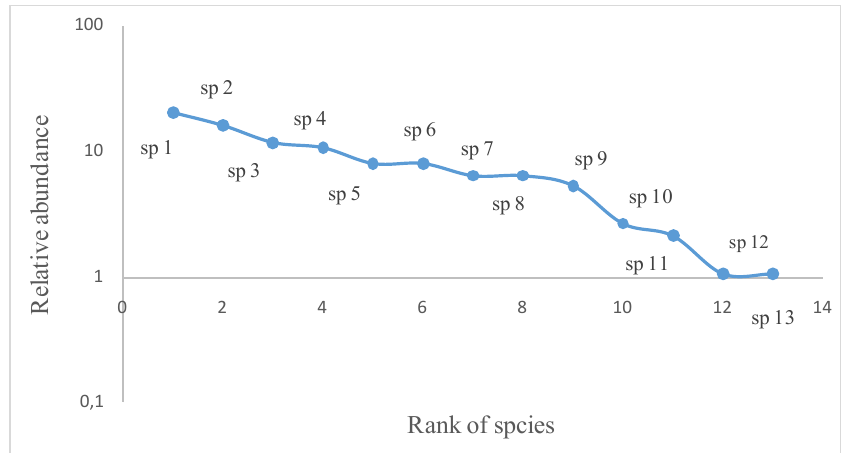
Fig 5. Rank-abundance curve for the relative abundance (Log10ni/N) of ant species collected in Assi-youcef. sp 1: Pheidole pallidula; sp 2: Tapinoma simorthi; sp 3: Palagiolepis schmitzi; sp 4: Cataglyphis viaticus; sp 5: Aphaenogaster senilis; sp 6: Messor barbarus; sp 7: Crematogaster sticularis; sp 8: Tetramorium bisekrens; sp 9: Camponotus toracicus; sp 10: Camponotus alii; sp 11: Camponotus barbarus; sp 12: Camponotus latiralis; sp 13: Aphaenogaster testaceopilosa .